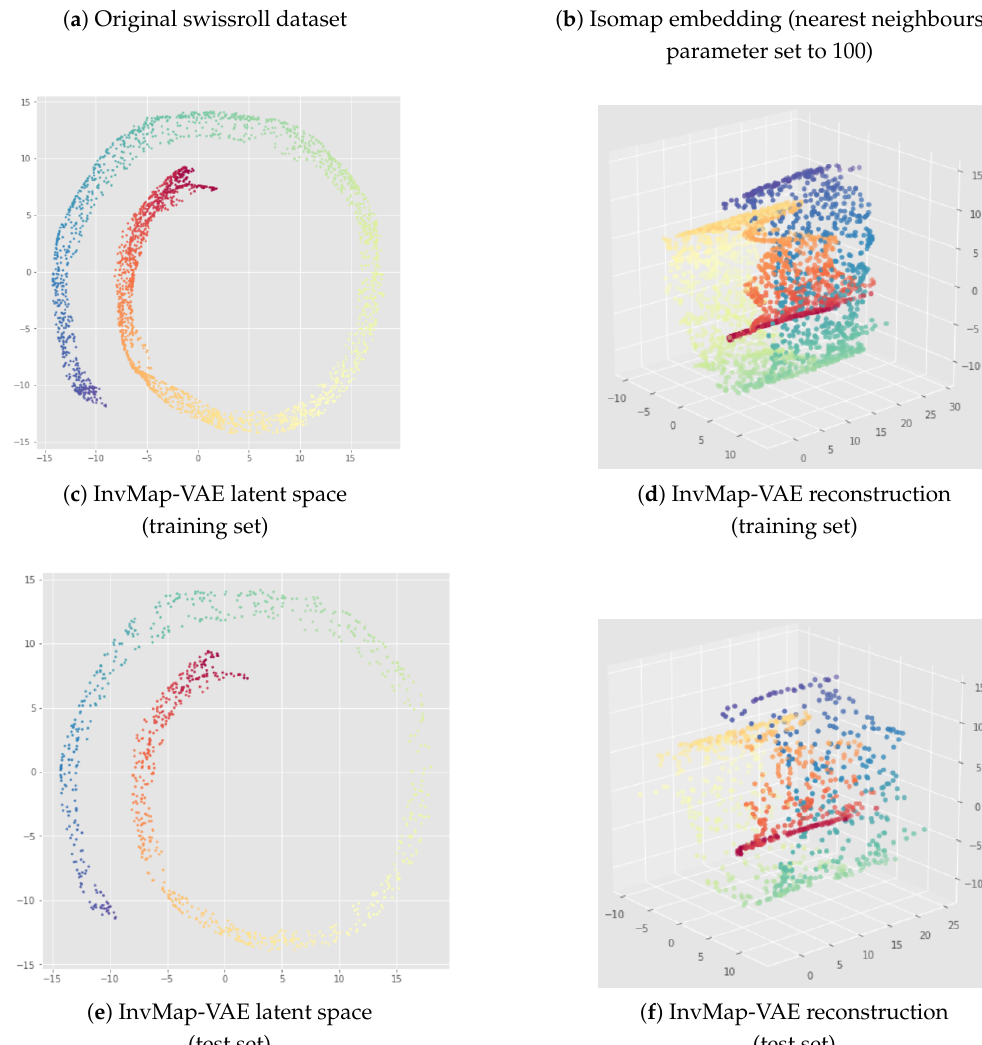
Figure 17. Isomap-based InvMap-VAE applied to the swissroll dataset, weight IM = 10 and trained for 1000 epochs. Betti numbers β 0 = 1 and β 1 = 0 are preserved between the original dataset ( a ), the latent representation (( c ) for training and ( e ) for test), and the reconstruction (( d ) for training and ( f ) for test). Moreover, on the contrary to the Isomap embedding ( b ), the latent representations are not too thin or “compressed”, which is better for